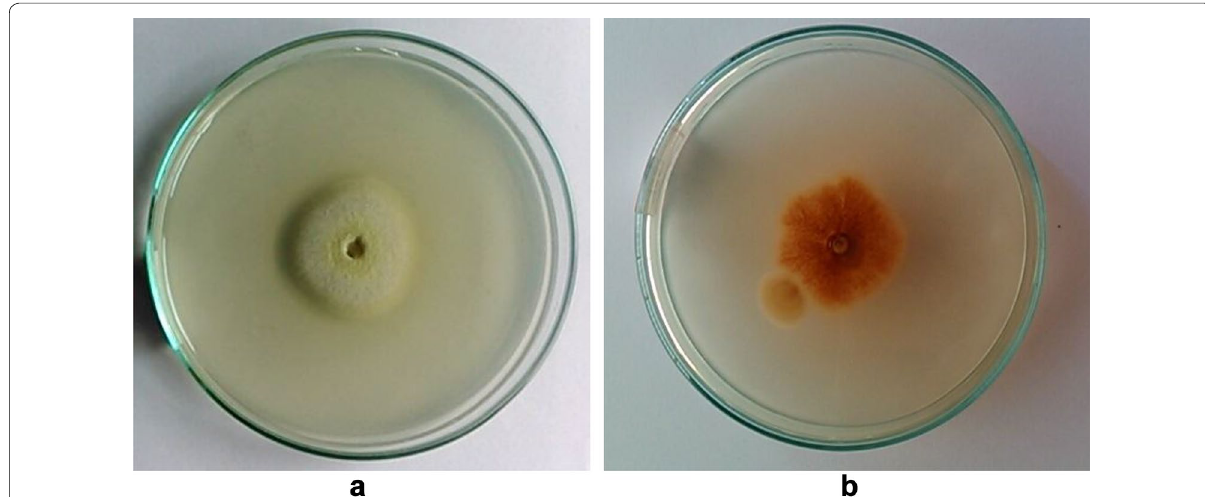
Fig. 5 Detection of laccase enzyme activity from the isolated fungal strain on agar plates. The appearance of the reddish brown zone around the colony indicates as a laccase-producing fungal strain on the 7th day. a Plate without guaiacol; b plate with guaiacol as a